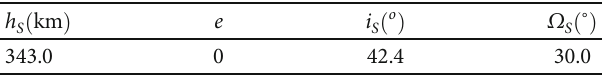
Figure 6: Flow chart of the hybrid optimization algorithm. Table 1: Orbital elements of an LEO space station. Table 2: Solutions for ETOs.